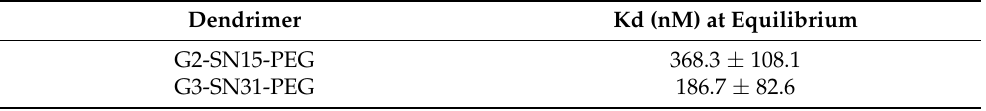
Figure 7. Surface plasmon resonance (SPR) analysis of G2-SN15-PEG- and G3-SN31-PEG-heparin interaction. ( a , b ) Sensorgrams showing the binding of G2-SN15-PEG and G3-SN31-PEG dendrimers (0.75 μ M) to the heparin- or BSA-coated flow cells. ( c , d ) Blank-subtracted sensorgram overlays showing the specific binding of increasing concentrations of the dendrimers (1: 0.047 µM; 2: 0.094 µM; 3: 0.188 µM; 4: 0.375 µM; 5: 0.75 µM; 6: 1.5 µM) to surface-immobilized heparin. The response (in resonance units, RU) was recorded as a function of time. ( e , f ) Saturation curves obtained using the values of RU bound at equilibrium from panels ( c , d ). Result of the competition assay with free heparin is also reported. Table 2. Kd values of the interactions of G2-SN15-PEG and G3-SN31-PEG dendrimers to heparin. Data corresponds to mean ± SEM of three individual experiments.